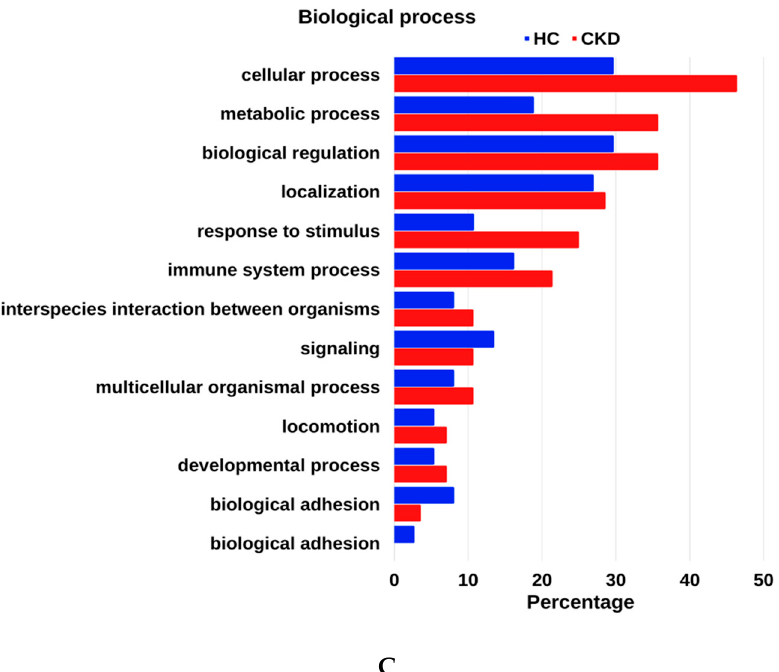
Figure 2. GO enrichment analysis of the 29 selected proteins in the CKD group (in red) and 37 proteins in the control group (in blue). ( A ) protein class. ( B ) cellular component. ( C ) biological process.